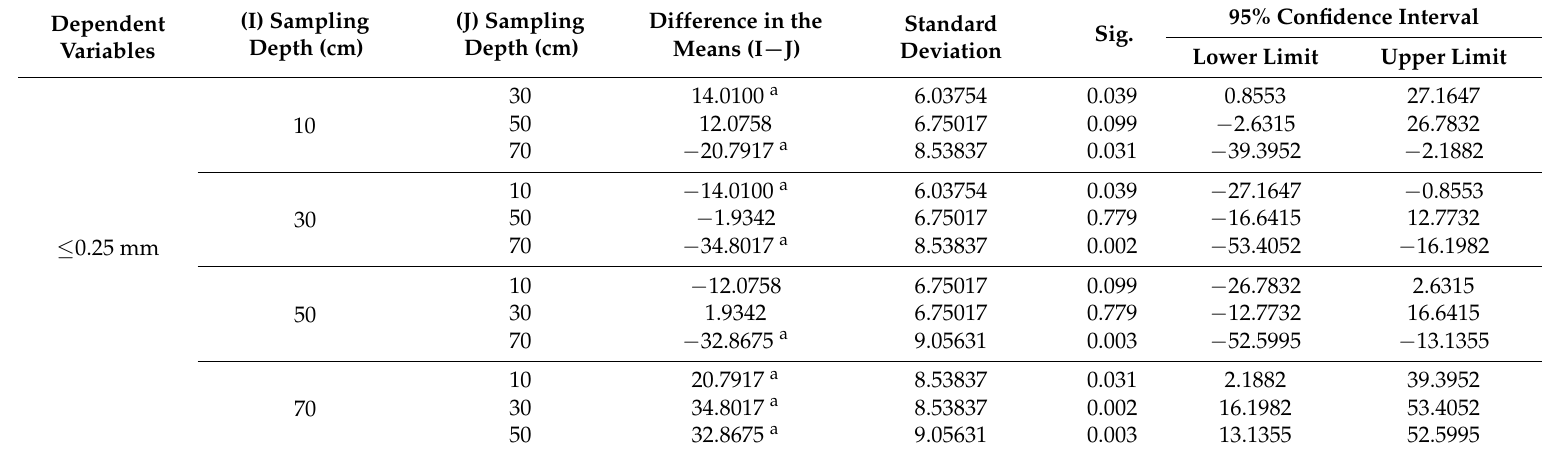
Table 3. Results of multiple comparative